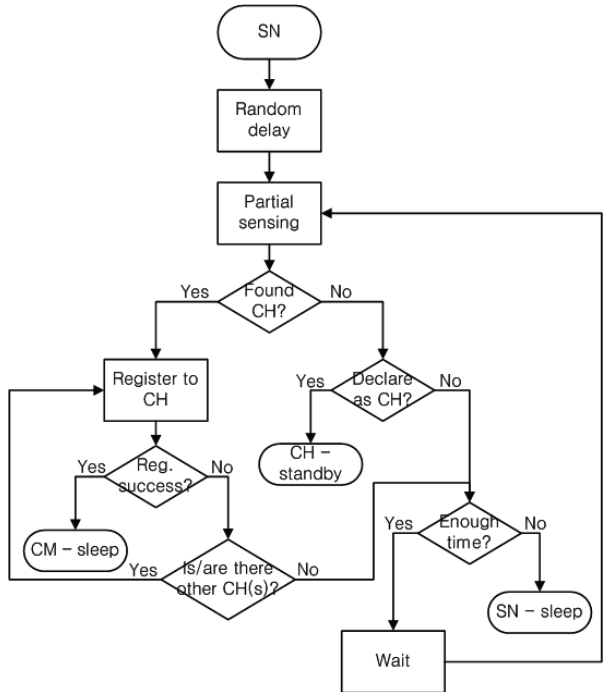
Figure 4. Procedural flow of the cluster formation